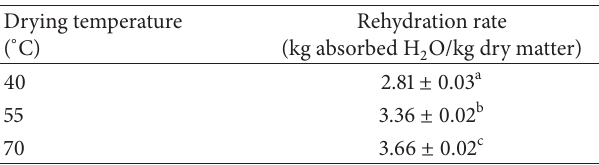
Table 4: Values of rehydration ratio (RR) obtained after drying (before storage) of galega kale at different